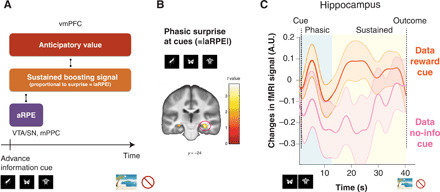
Neural correlates of our computational model’s surprise that can boost anticipation utility in our computational model.(A) Our model predicts that a surprise, quantified by the absolute value of aRPE, can boost the utility value of anticipation. The model predicts the effect of boosting to be sustained during the anticipatory period, in contrast to the phasic, short, aRPE signal. (B) A surprise at advanced information cues, quantified by the absolute value of aRPE, significantly correlated with BOLD in the hippocampus [FWE, P < 0.05, small volume correction (46)]. (C) The temporal dynamics of fMRI signal in the hippocampus. Changes in activity averaged over participants after receiving a reward predictive cue (orange), and after receiving a no-information cue (magenta), are shown. The phasic response confirmed in (B) is apparent in the early phase of the delay period (blue). Still, the coding of boosting-related value is sustained throughout the entire waiting period (blue and yellow), which is what our model predicted. The error bar indicates the SEM. Please also see fig. S14 for responses to a no-reward predictive cue.